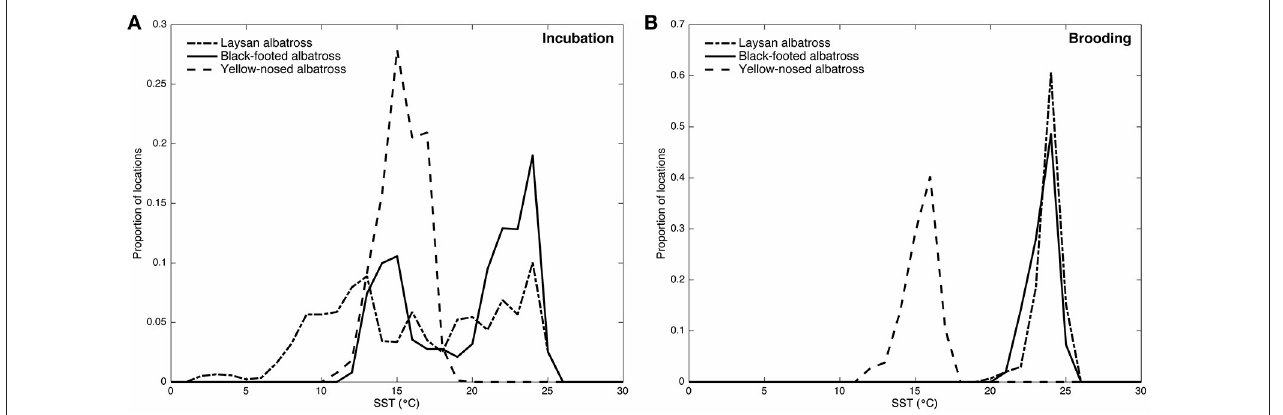
FIGURE 2 | Distribution of sea surface temperatures ( ◦ C) along Laysan, black-footed, and Indian yellow-nosed albatrosses foraging routes during incubation (A) and brooding (B) . Laysan and black-footed albatrosses were tracked at Tern Island, Northwest Hawaiian Islands during 2002–2003, 2004–2005, and 2005–2006, and yellow-nosed albatrosses were tracked at Amsterdam Island, southern Indian Ocean, during 2006–2007. Blended 5-day sea surface temperature retrieved via the NOAA OceanWatch Live Access Server (http://coastwatch.pfel.noaa.gov/erddap/).